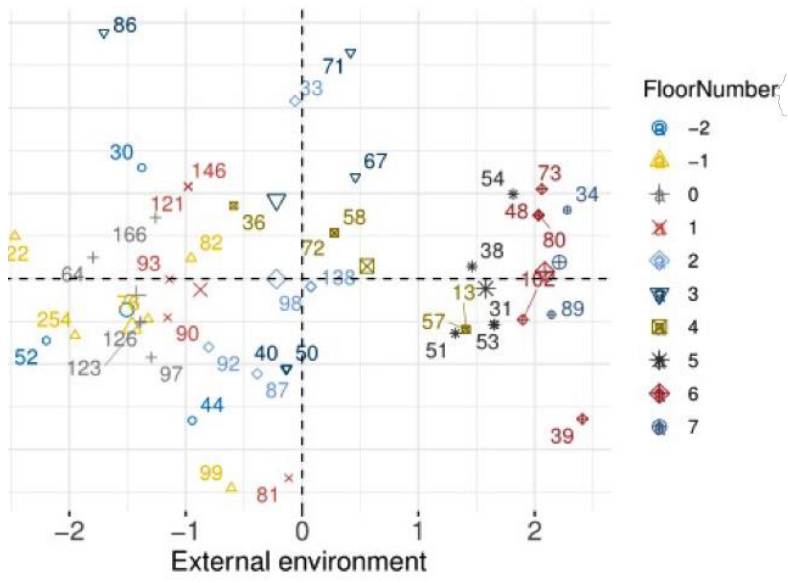
Figure 6. Factor map of the first analysis with differentiated individuals according to the plan.